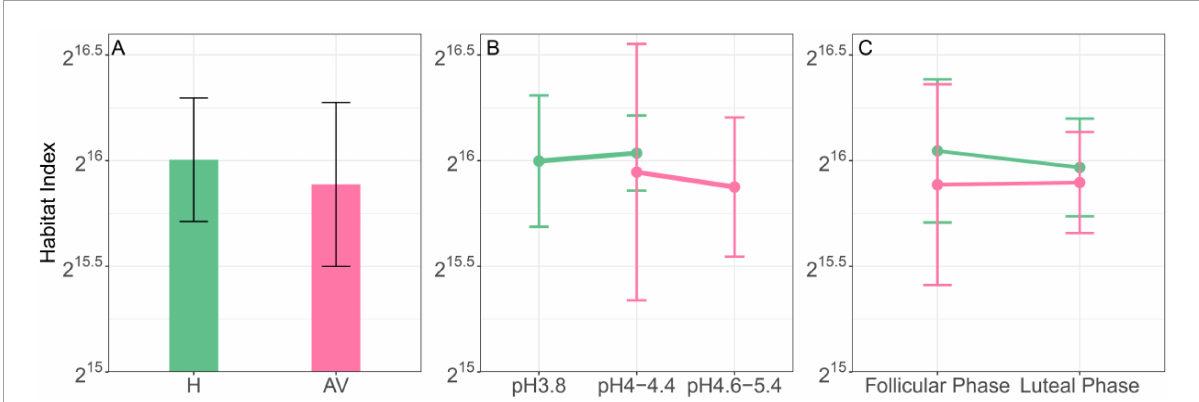
FIGURE1 Habitat index as a predictor of AV risk. (A) Difference between the healthy (H) and AV groups. (B) Change as a function of pH values in two groups. (C) Difference due to the cyclic change from follicular to luteal phases for each group. Standard errors in each case are shown. Green and red lines represent H and AV groups, respectively.